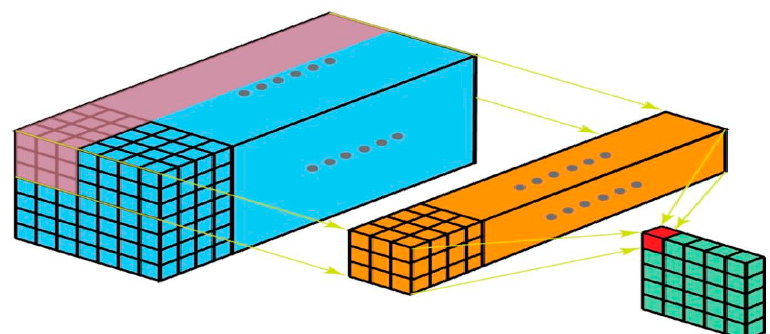
Figure 10. 2D convolution.